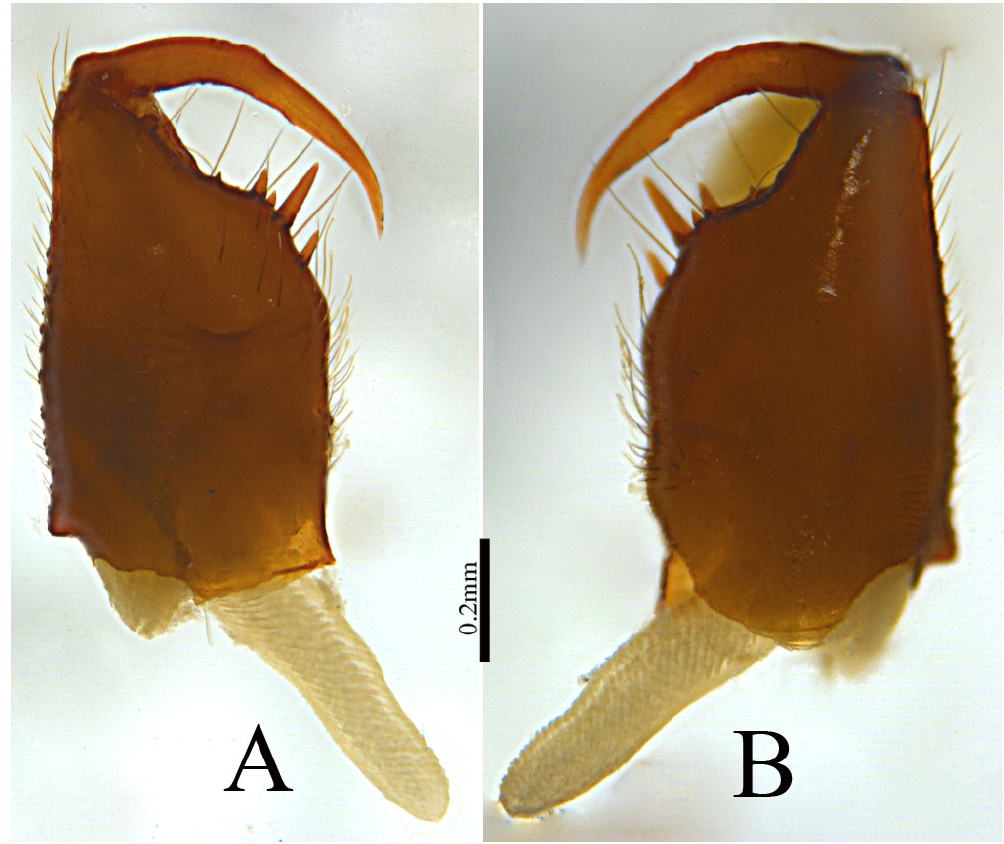
Fig. 25. Acroterius latus gen. et sp. nov., ♂, holotype (HNU-CGY123). A . Chelicera, dorsal view. B . Chelicera, ventral